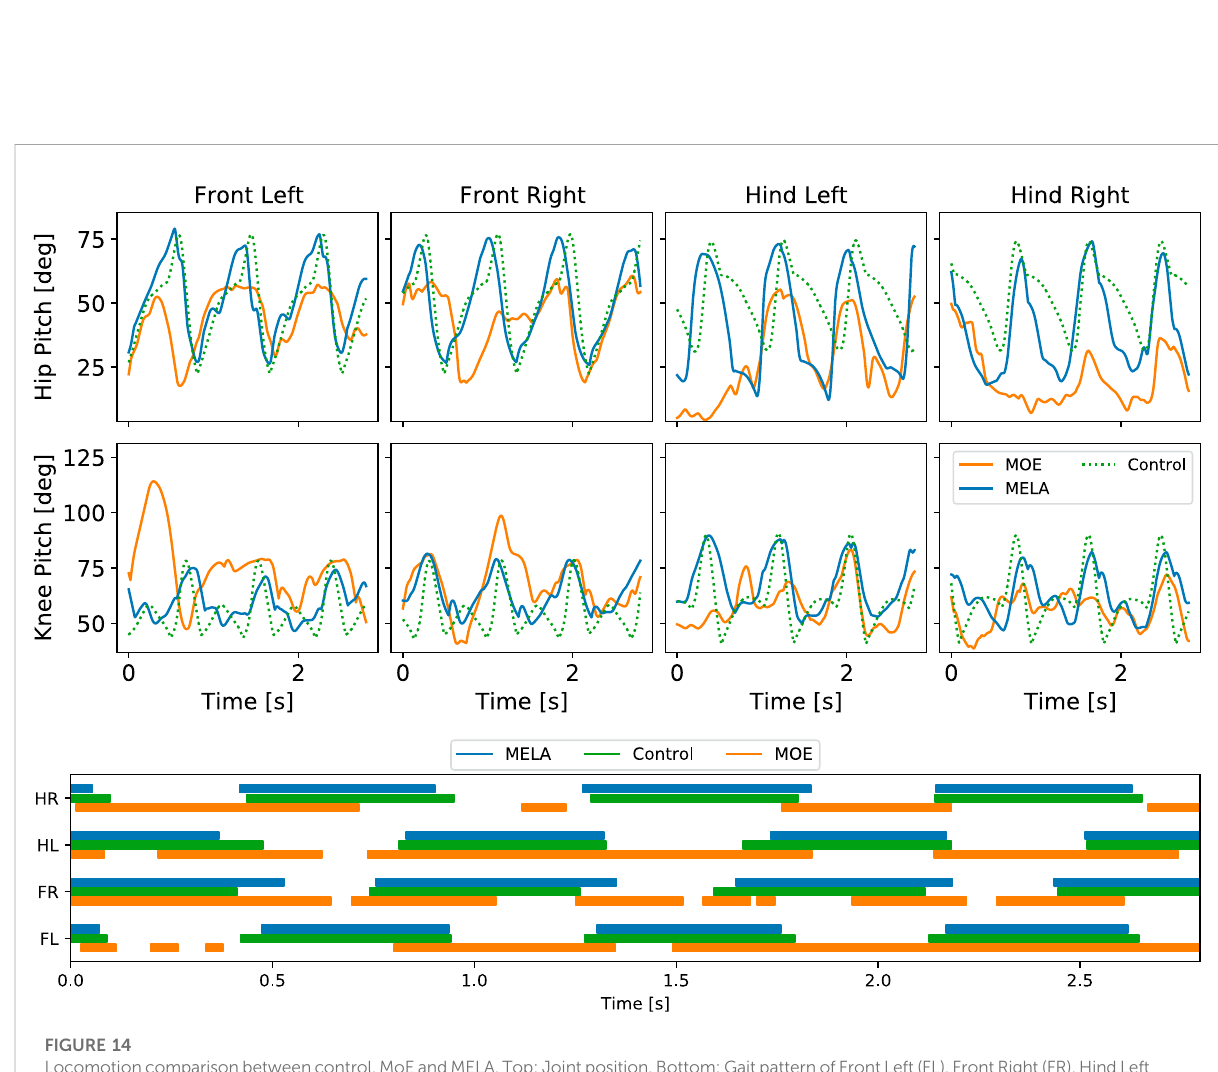
FIGURE 14 Locomotioncomparisonbetweencontrol,MoEandMELA.Top:Jointposition.Bottom:GaitpatternofFrontLeft(FL),FrontRight(FR),HindLeft (HL), Hind Right (HR)